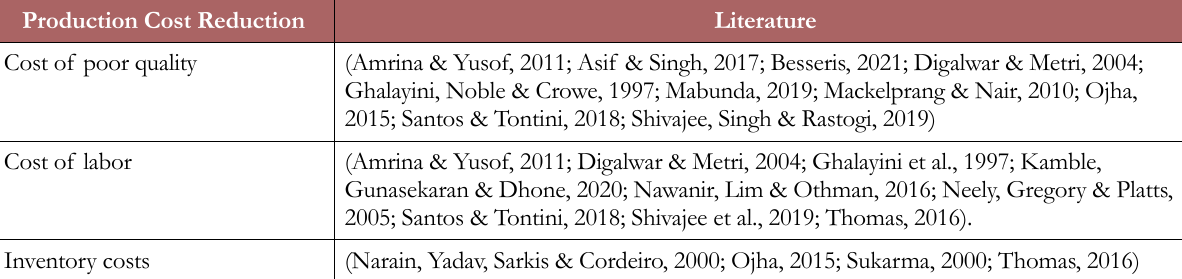
Table 1. Summary of articles in